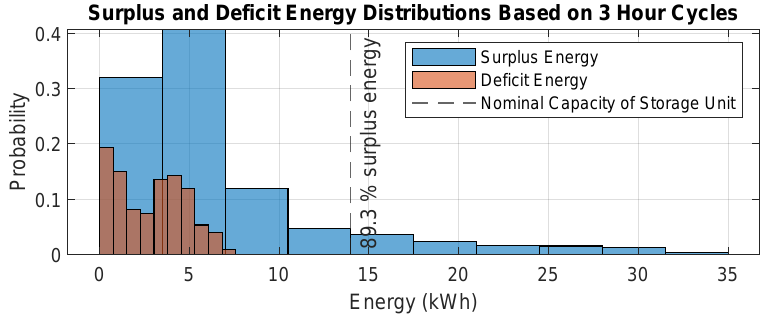
Figure 6. The deficit and surplus energy distributions of the microgrid based on 3 h